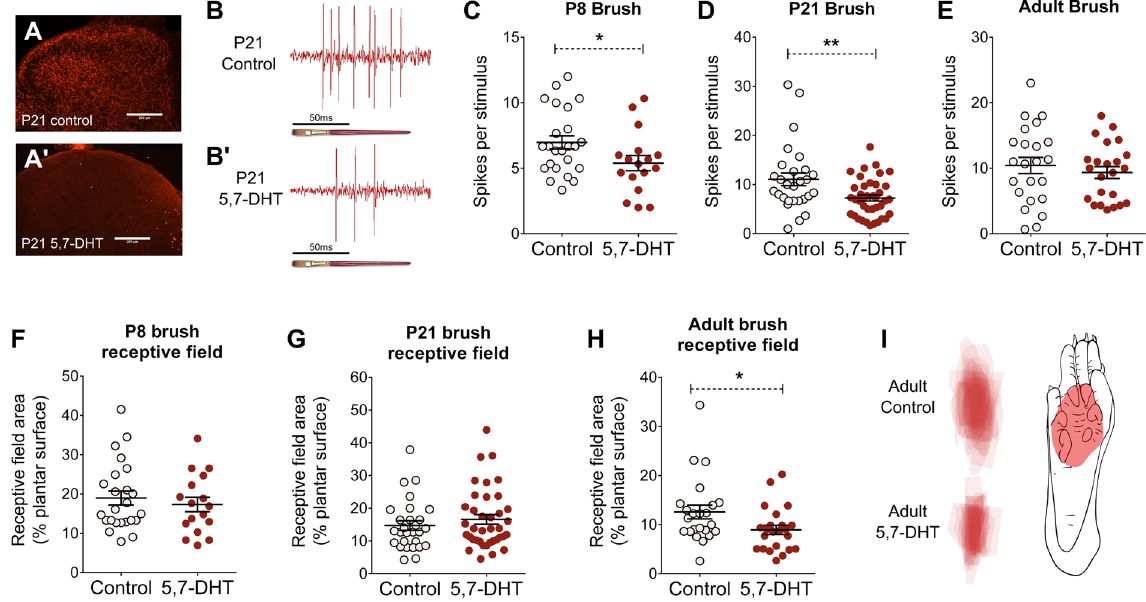
Figure 1. Serotonergic facilitation of dorsal horn neuron brush-evoked activity in young and adult rats. Hindpaw brush-evoked extracellular recordings of wide dynamic range (WDR) neurons were performed in laminae IV-VI of the lumbar spinal dorsal horn at P8, P21 and in adult P45 rats. 5-HT transporter (5-HTT) serotonergic terminals (red) were present in the dorsal horn of saline injected animals ( A ), but not in animals treated with 5,7-DHT (A ′ ). Scale bar = 200 μ m. Typical brush-evoked dorsal horn neuron spikes in P21 control rats ( B ) and 5,7-DHT treated rats (B ′ ). Brush-evoked firing activity was lower in 5,7-DHT-treated animals at P8 ( C ) and P21 ( D ), but not in adult rats ( E ). Brush receptive field area was smaller than controls in 5,7-DHT- treated adults ( H ), but not at P8 ( F ) or P21 ( G ). Receptive fields of dorsal horn neurons in control and 5,7-DHT- treated adult groups were overlaid and mapped onto a standardised paw template to create a heat map for each group ( I ). A typical dorsal horn neuron brush receptive field from an adult control rat is shown for scale Bars indicate mean ± SEM. * , ** P < 0.05,